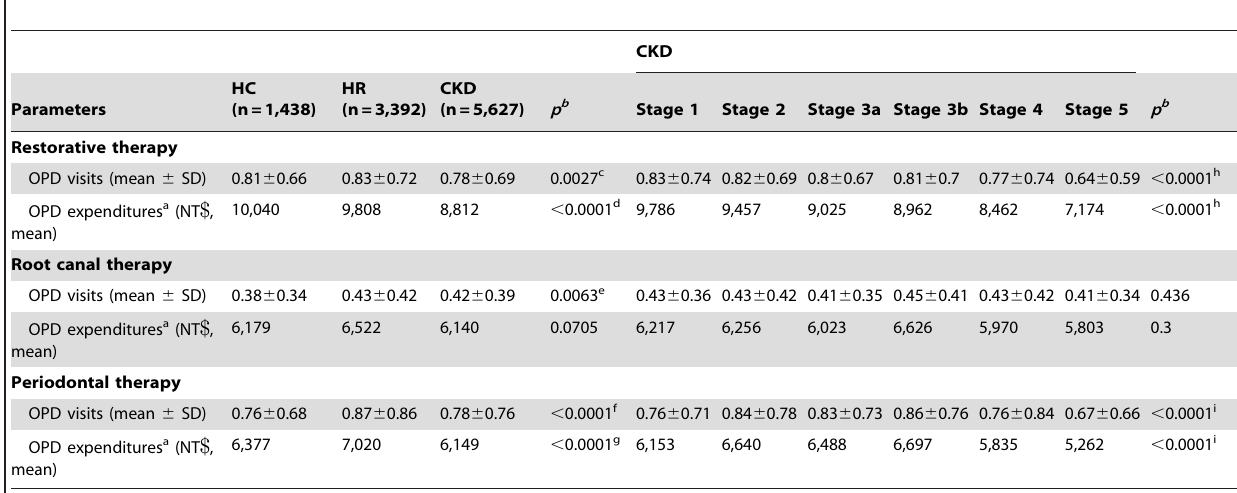
Table 4. The average annual number of OPD visits, and expenditures per person of different dental procedures among eligible patients and different CKD stages from 2000 to